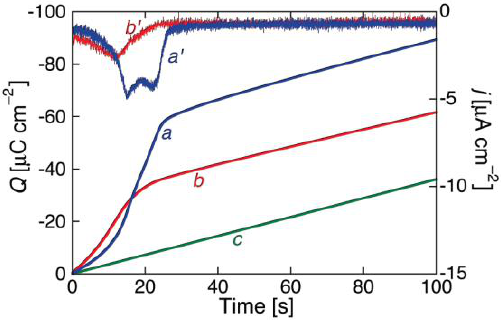
Figure 9. Charge transients following potential steps from E i = −0.30 V to two different final potentials E f at a DPTL/DOPS tBLM in a pH 3 solution of 0.1 M KCl and 0.8 μM SR-E. (a) Pristine potential step to E f = −0.90; (b) potential step to E f = −0.75 V recorded immediately after a potential step from −0.30 to −1.00 V and a rest time of 30 s at E i . The curves a′ and b′ are the corresponding current transients. Curve c is the charge transient from −0.30 V to −1.00 V in the absence of SR-E under otherwise identical conditions. (Reprinted and minimally adapted with permission from [57]. Copyright 2015, Elsevier). While SR-E forms voltage-gated channels, syringopeptin 25A (SP25A), another lipodepsipeptide with a longer peptide chain produced by the Gram-negative bacterium Pseudomonas syringae pv.